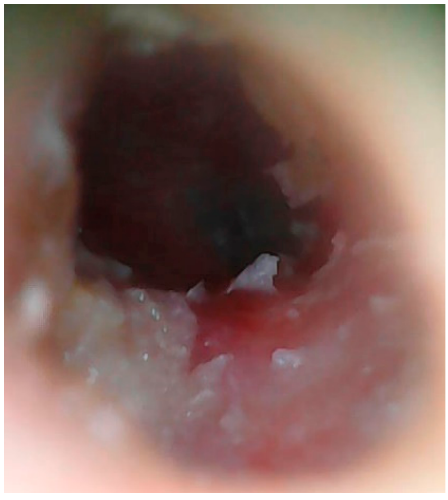
Figure 5. Post operative image 3 months after TEES (adequate re-epithelialization of the EAC.)